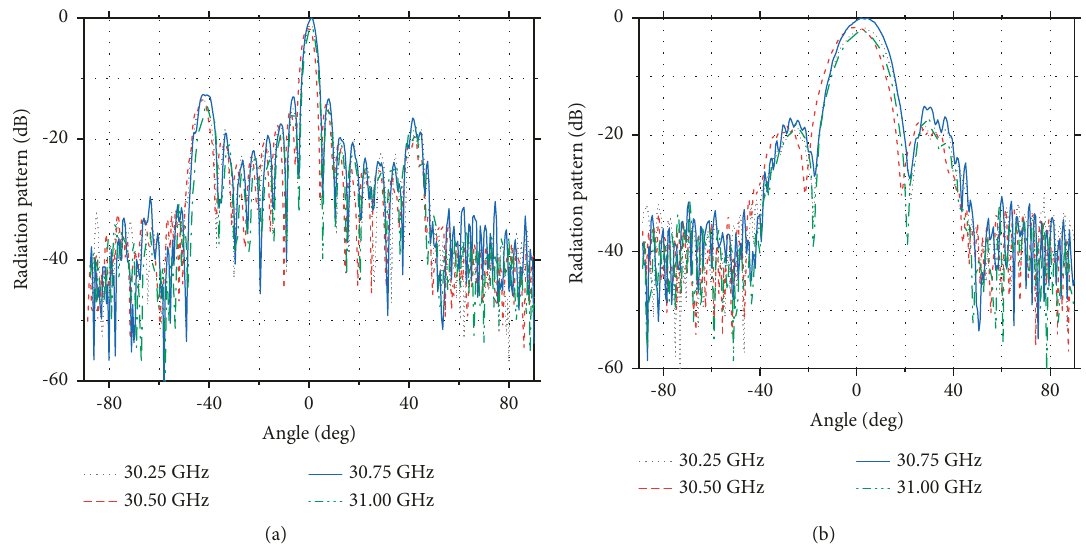
Figure 12: Radiation patterns of the 2